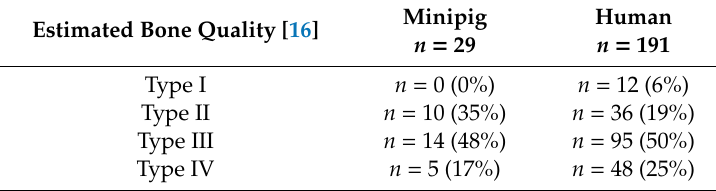
Table 2. Estimated bone quality according to Lekholm and Zarb [16].